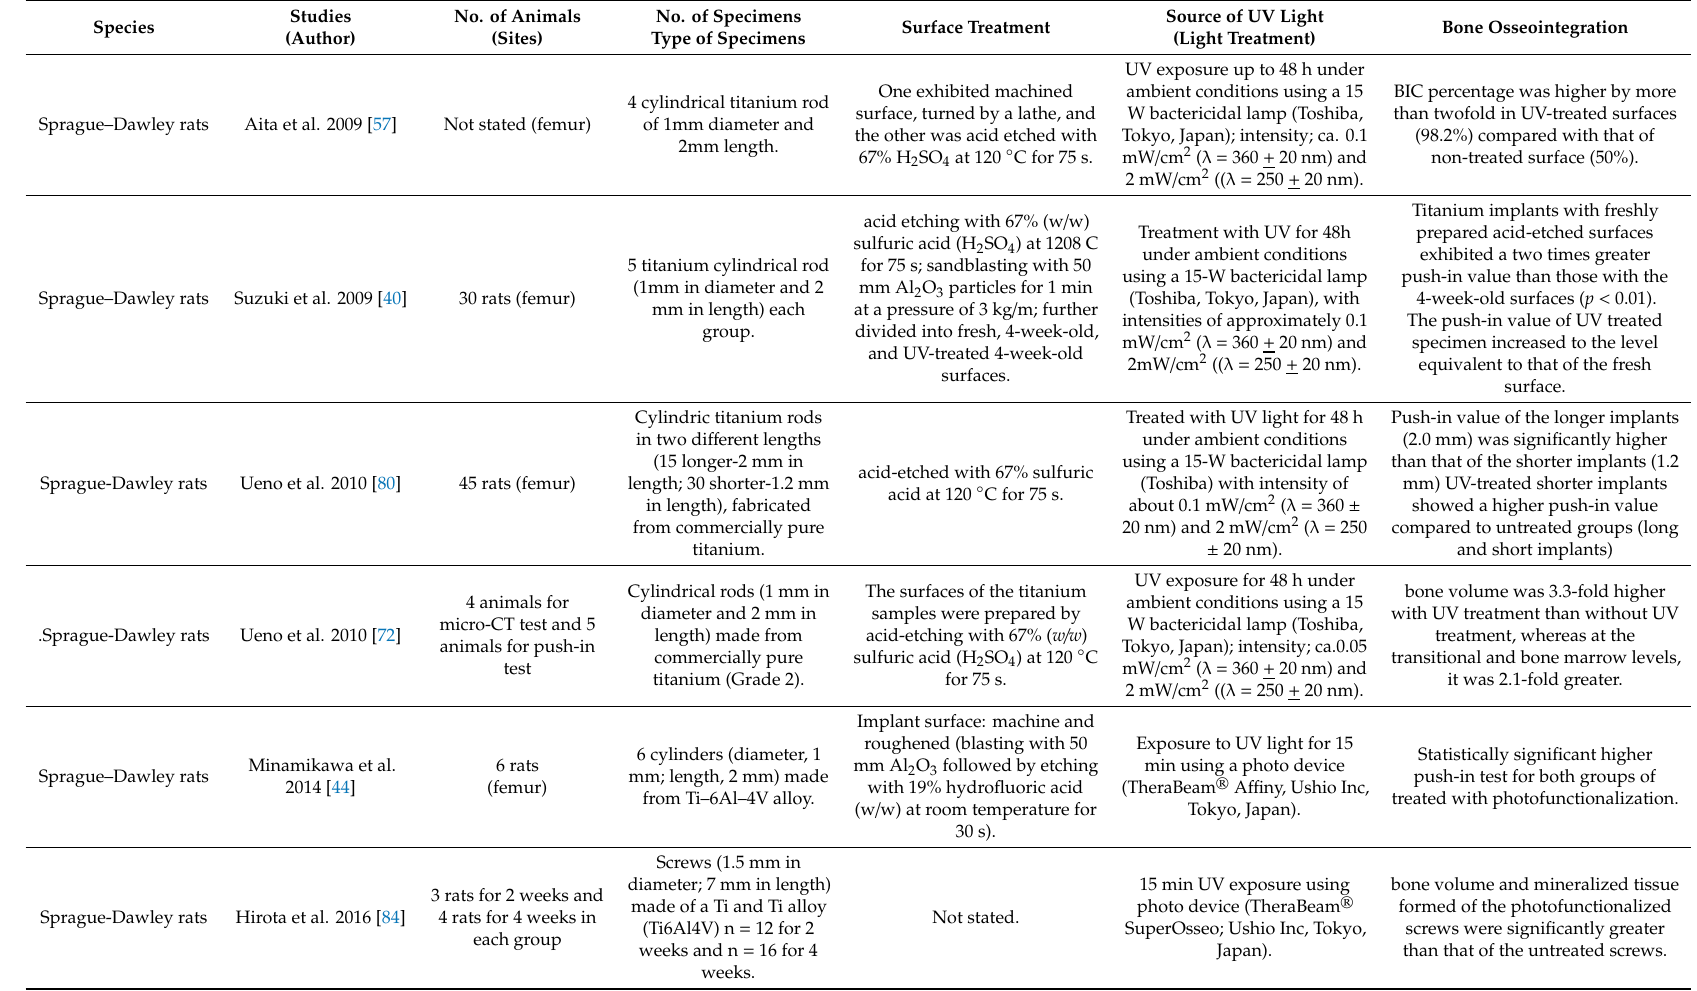
Table 1. E ff ect of UV photofunctionalization on rat